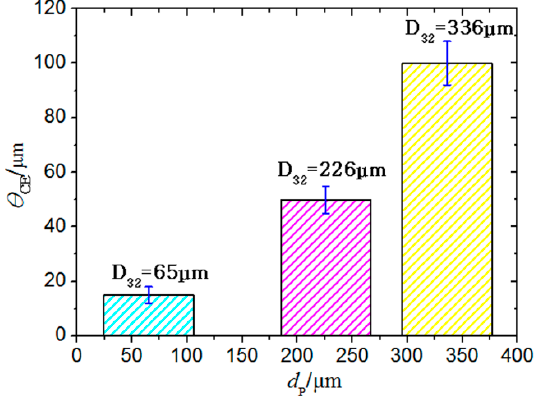
Figure 14. Thickness of the erosion layer as a function of the diameter of the erodent particles.